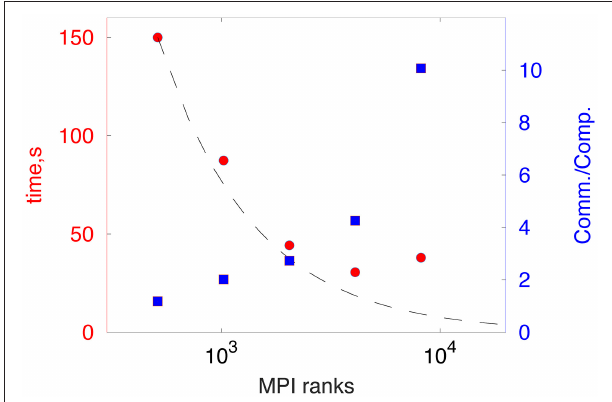
FIGURE 2 | Example of strong scalings of SPS obtained on Electra supercomputer. Red circles represent computation time, blue squares mark the ratio of communication to computation time, and dashed lines denote ideal